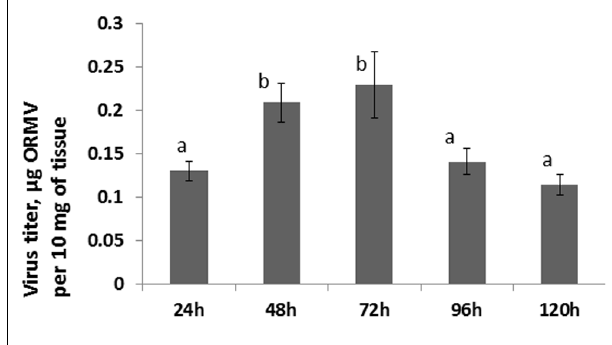
FIGURE 4 |Viral titer in infected leaves. Plants from line 15d8 were infected with 100 ng ORMV, and a viral titer was measured in infected leaves at different time points from 24 to 120 hpi.The data are shown in microgram of ORMV per 10 mg of plant tissue (calculated from four plants per each of three repetitions, with SE).The letters indicate whether there is a significant difference between time points in the virus-treated